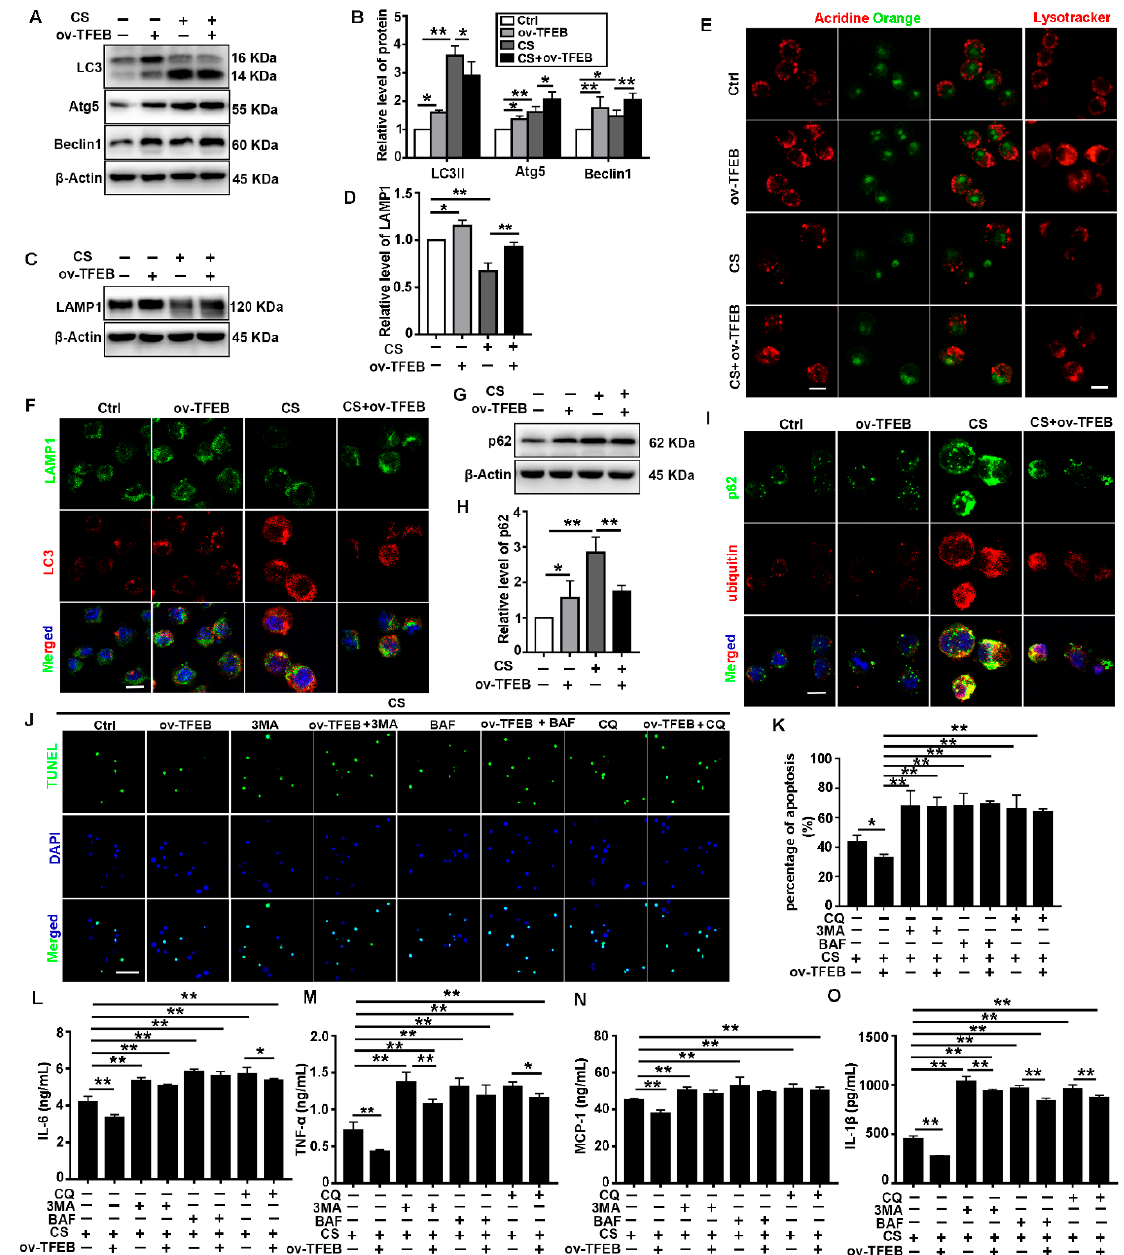
Figure 3. TFEB overexpression relieves CS ‐ induced macrophage apoptosis and inflammation via autophagic substrate degradation in vitro. ( A , B ) Immunoblotting analysis of LC3II, Atg5, and Beclin 1 protein levels ( n = 4). ( C , D ) Immunoblotting analysis of LAMP1 protein levels ( n = 3). ( E ) Cells were grown on coverslips and treated with CS followed by staining with 50 nmol/L Lysotracker Red or 5 μ g/mL acridine orange at 37 °C for 30 min (scale bar = 10 μ m and n = 4). ( F ) Immunofluorescence analysis of the colocalization of LAMP1 and LC3 12 h post CS treatment (scale bar = 25 µ m and n = 4). ( G , H ) Immunoblotting analysis of p62 protein levels ( n = 4). ( I ) Immunofluorescence analysis of the colocalization of the p62 and ubiquitin 12 h post CS treatment (scale bar = 25 µ m and n = 4). (J , K ) TUNEL (green) and DAPI (blue) staining and ratios of TUNEL-positive apoptotic cells (scale bar = 50 µ m and n = 4). ( L – O ) ELISA analysis of IL-6, MCP-1, TNF- α , and IL-1 β levels in MH-S cell supernatant ( n = 3 to 4). Data are presented as the mean ± SD. *, p < 0.05 and **, p <